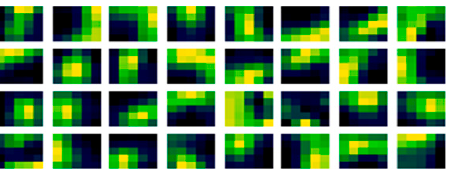
Figure 5. Learned filter weight adaption-updates of the existing random method.